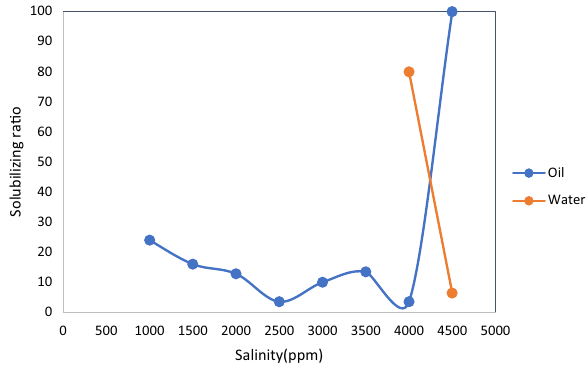
Fig. 5 Solubilizing ratio w.r.t salinity of the NIS